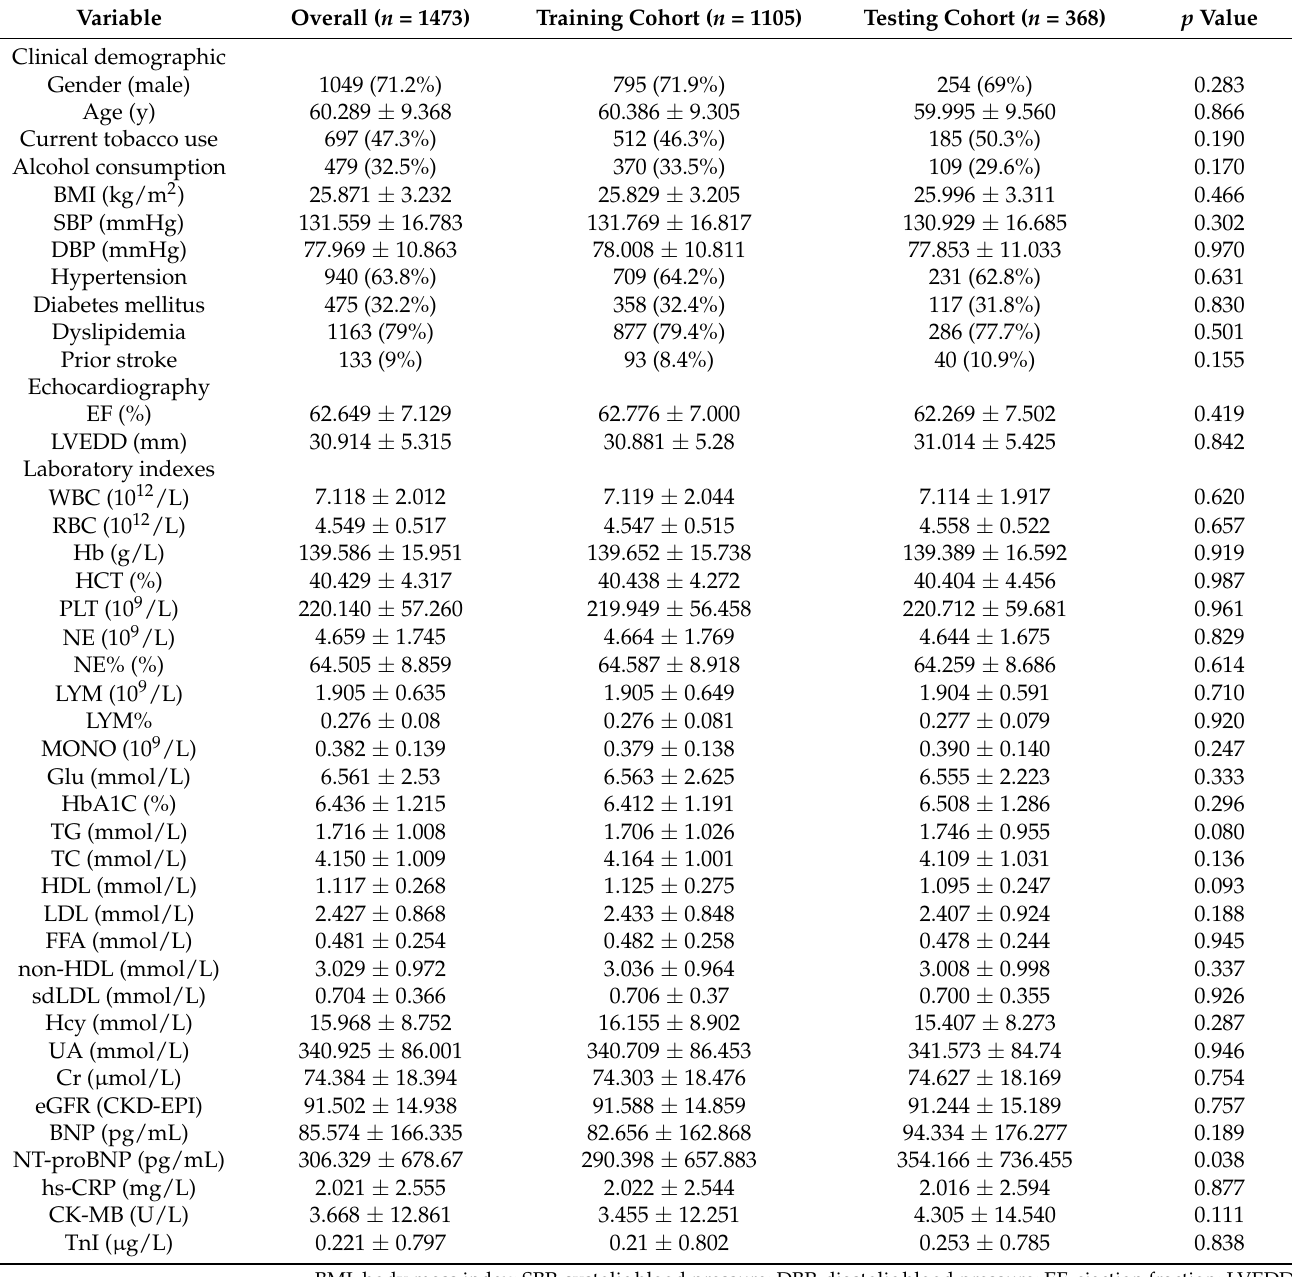
Table 4. Baseline clinical characteristics of the training and testing